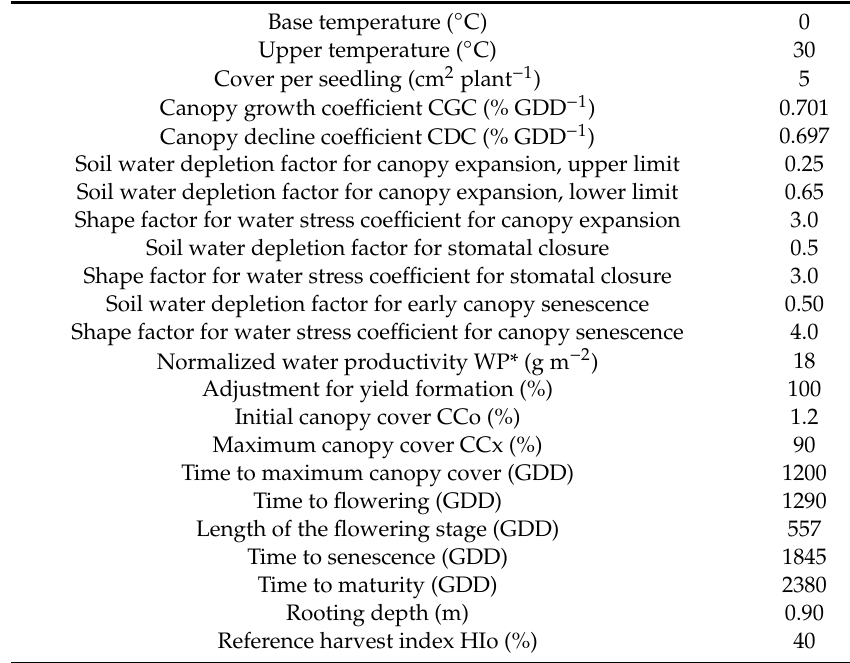
Table 4. AquaCrop calibration parameters and their respective values for faba bean (cv.